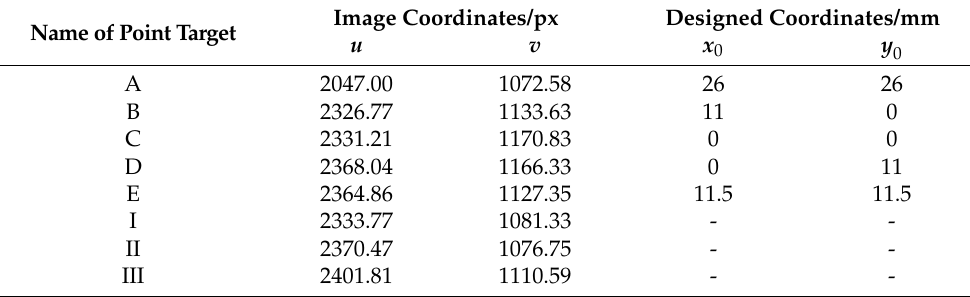
Table 3. Image coordinates and designed coordinates of template